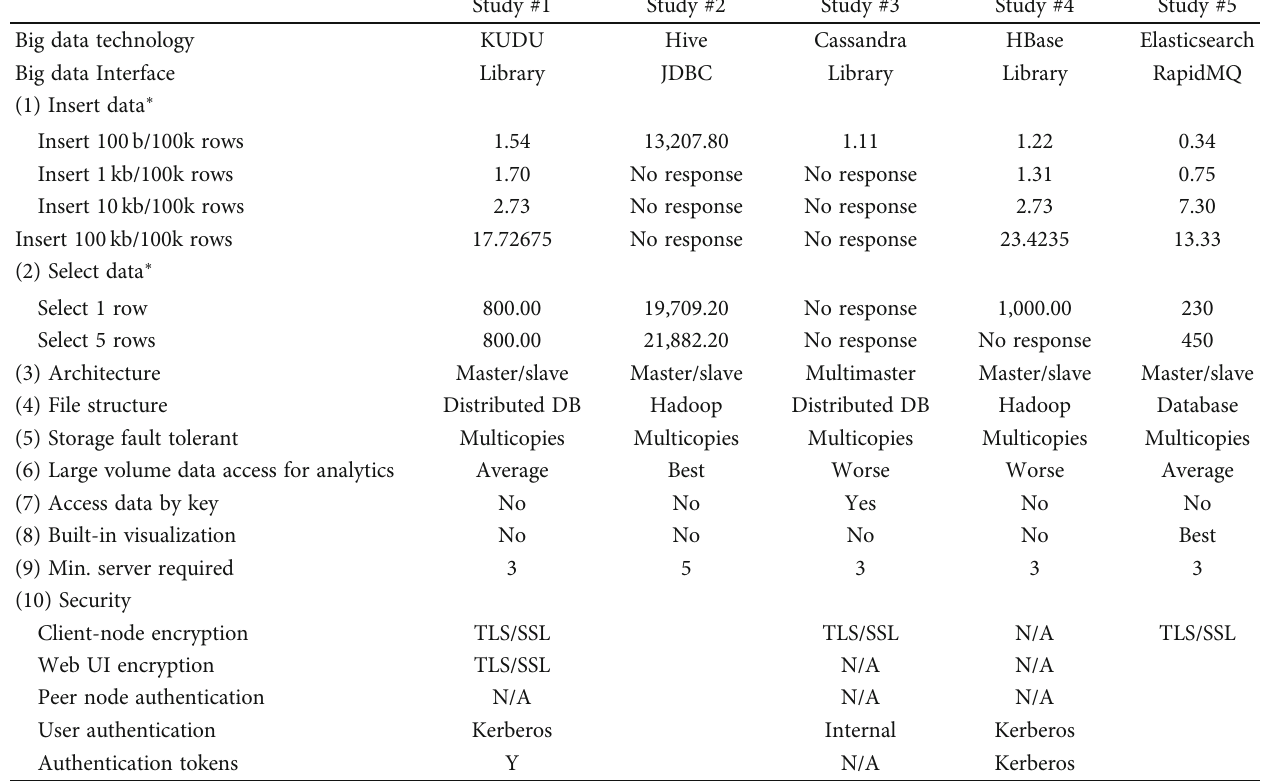
Table 2: Big data technology comparisons for IoT streaming in